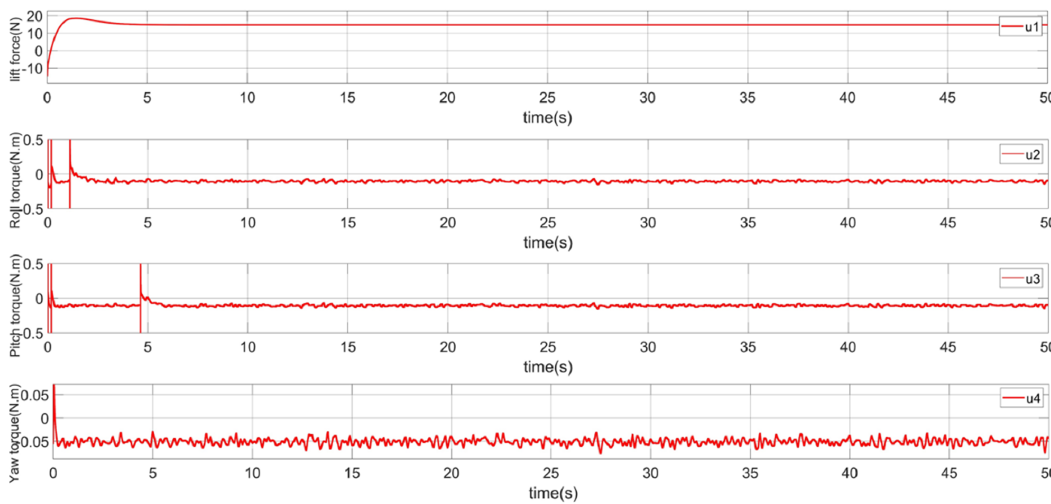
Figure 22. The control outputs of the proposed controllers.